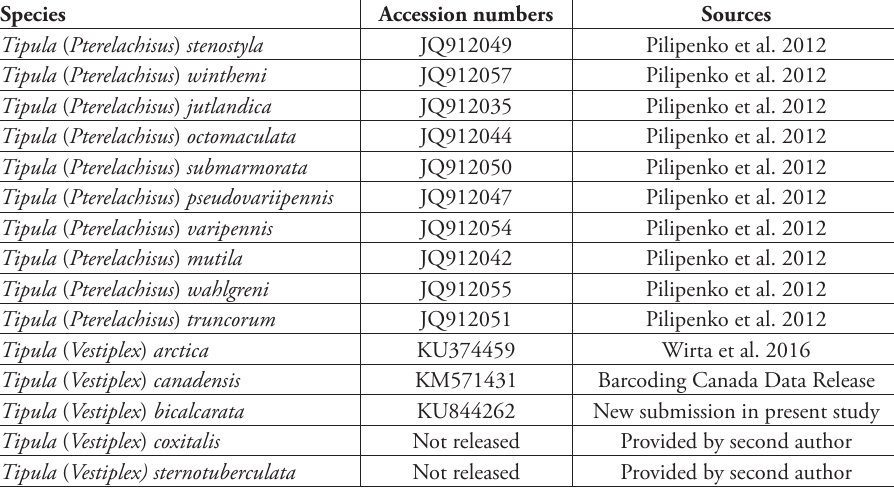
Table 1. Accession numbers and sources of COI sequences of some known species in Tipula ( Pterela- .( chisus ) and Tipula (